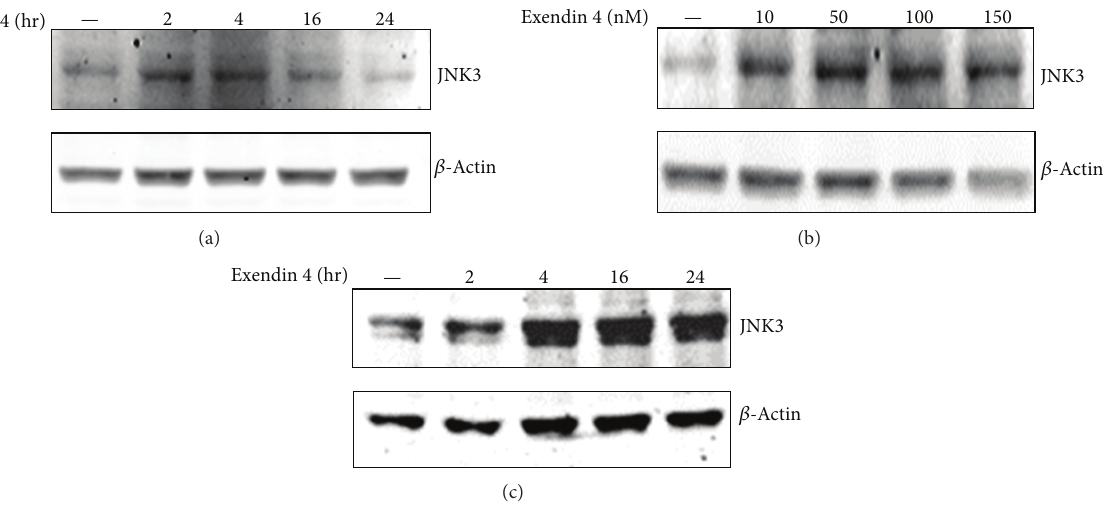
Figure1:Theeffectofexendin4ontheJNK3content.JNK3abundancein(a)isolatedhumanislets(fromthreedifferentdonors)culturedwith 50 nM exendin 4 for the indicated times or (b) with different exendin 4 concentrations for 4hrs. (c) INS-1E cells cultured with 50nM exendin 4 for the indicated times. For western blotting experiments, protein extracts (50 𝜇 g) were loaded into a polyacrylamide gel electrophoresis. Immunoblotting was achieved using the anti-JNK3 and anti- 𝛽 -actin antibodies. The data is one representative experiment out of three.